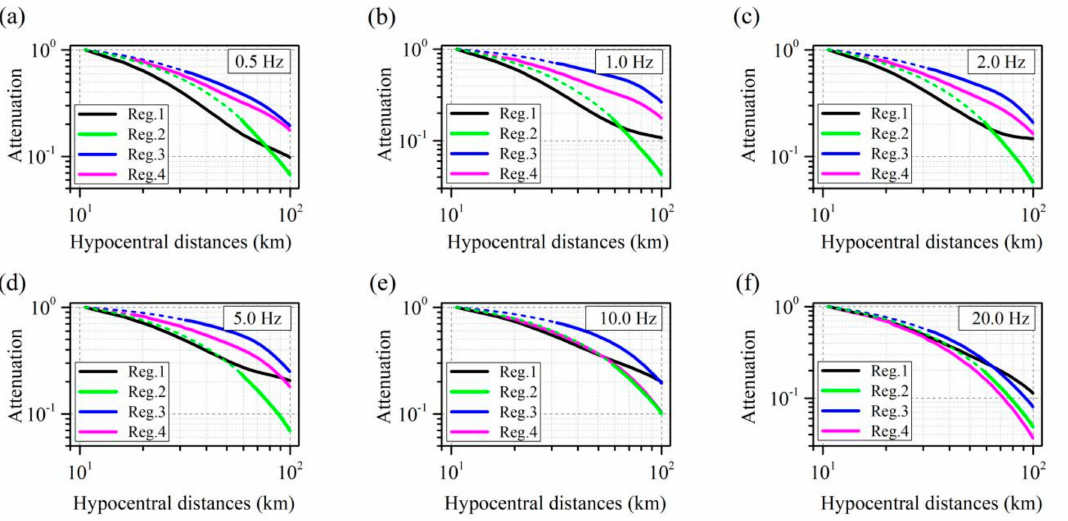
Figure 8. Attenuation curves of Reg.1, Reg.2, Reg.3, and Reg.4 for six frequencies, which are ( a ) 0.5 Hz, ( b ) 1.0 Hz, ( c ) 2.0 Hz, ( d ) 5.0 Hz, ( e ) 10 Hz, and ( f ) 20